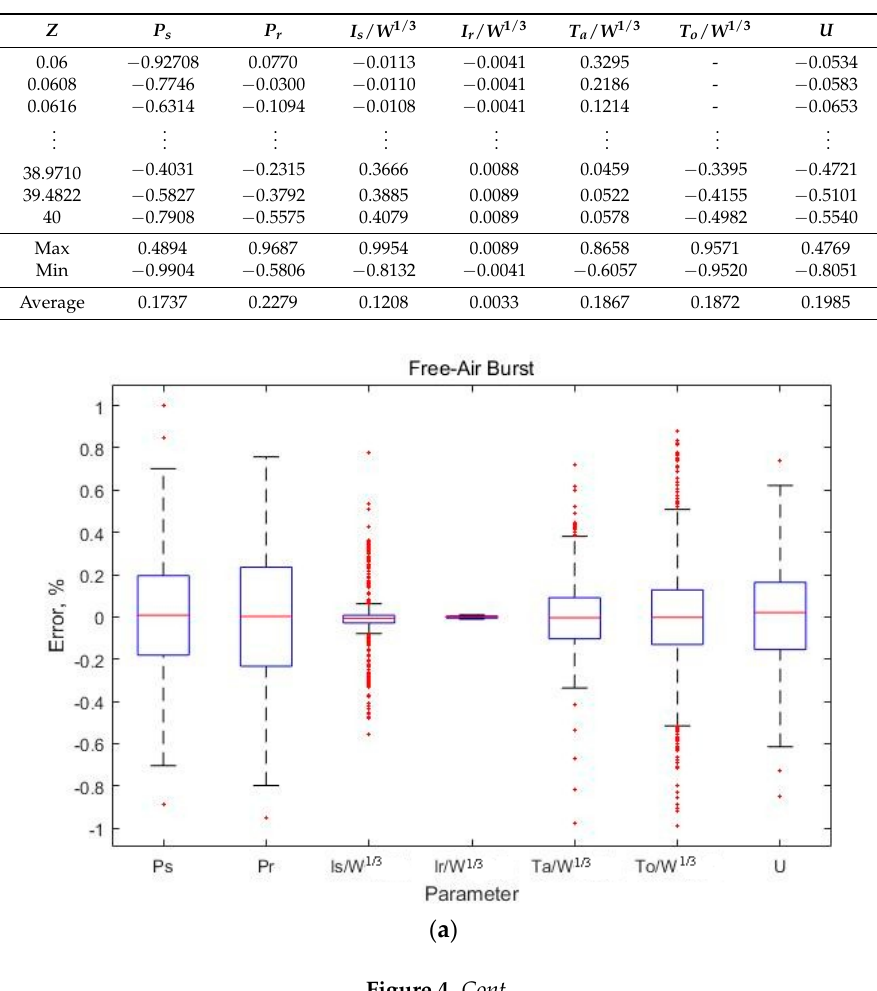
Table 6. Error of Modified Equation for Surface Burst (Unit: %).